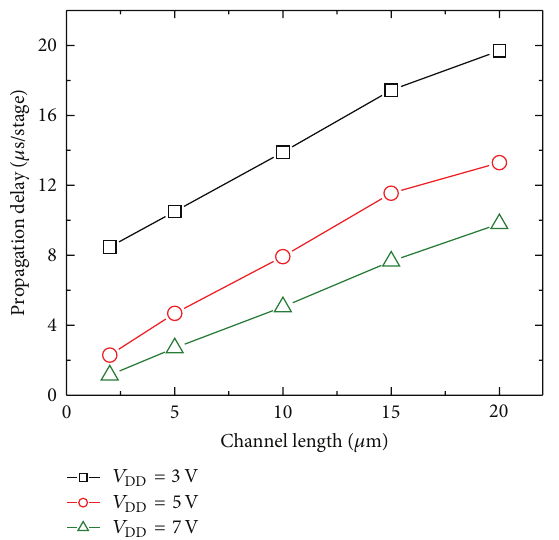
Figure 9: Variation of propagation delay with channel length in three-stage ring oscillators for different values of supply voltage.